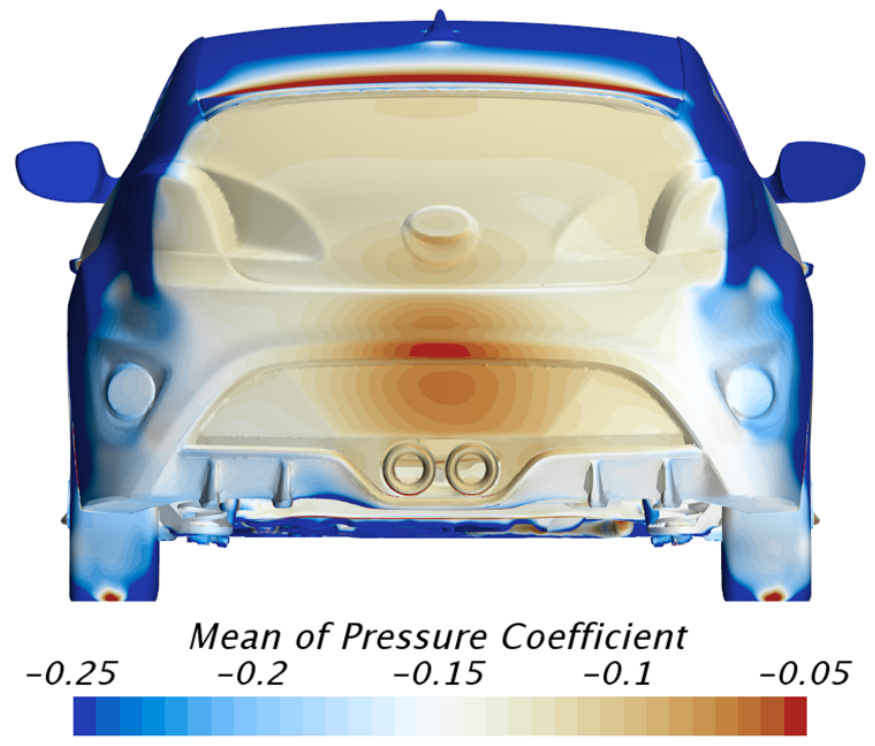
Figure 12. The pressure coefficient from the RKE model on the back of the vehicle for the baseline case.